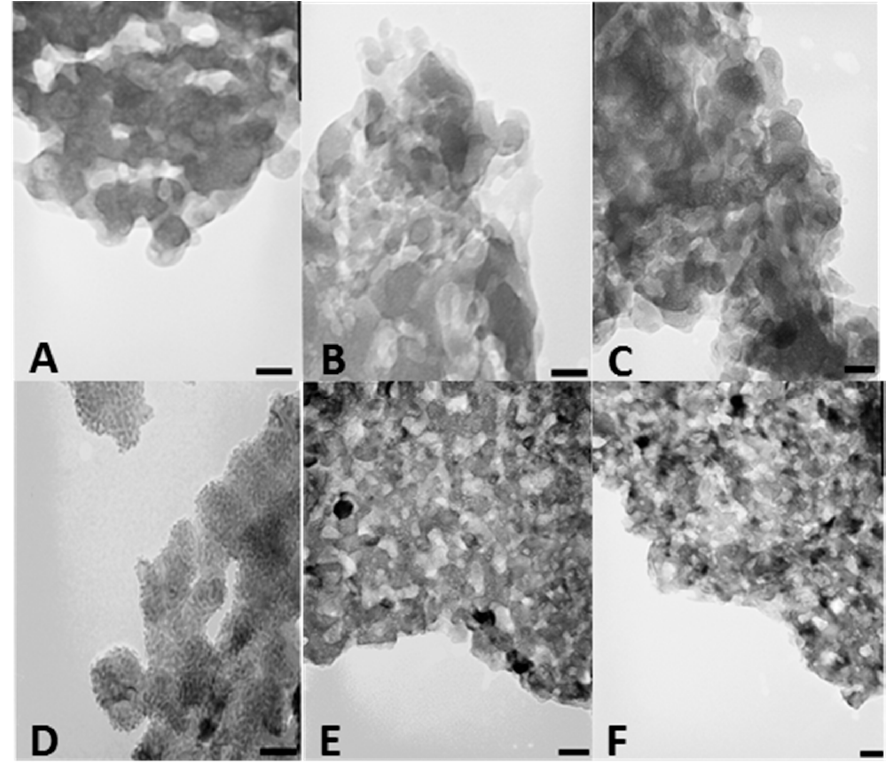
Figure 3. TEM micrographs of CSCaP1OP ( A ); CSCaP2OP ( B ); CSCaP3OP ( C ); CSCaP1C ( D ); CSCaP2C ( E ) and CSCaP3C ( F ). Bars are 50 nm.